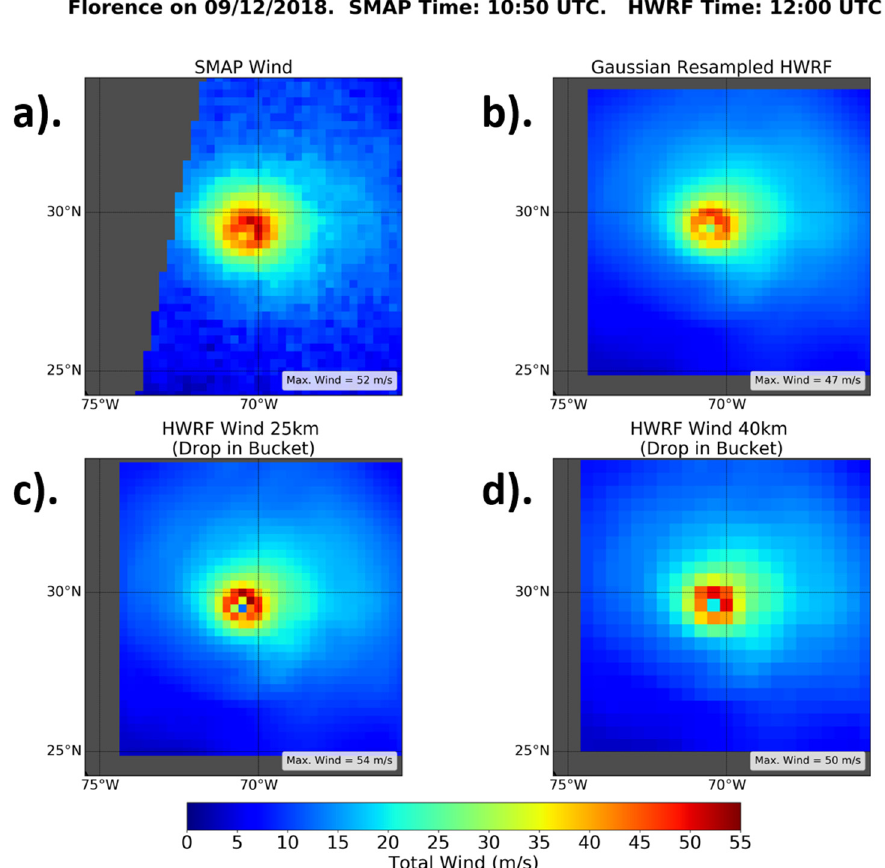
Figure 4. Various methods of resampling the HWRF data from its native resolution for a sample view of Hurricane Florence on 12 September 2018 at 12:00 UTC. ( a ) The SMAP pass over Hurricane Florence approximately 1 h before the HWRF time shown in ( b – d ), ( b ) HWRF resampled using a Gaussian weighting method with a 40 km half-power width, ( c ) resampling using a 25 km drop-in-the-bucket box average, and ( d ) resampling using a 40 km drop-in-the-bucket box average.